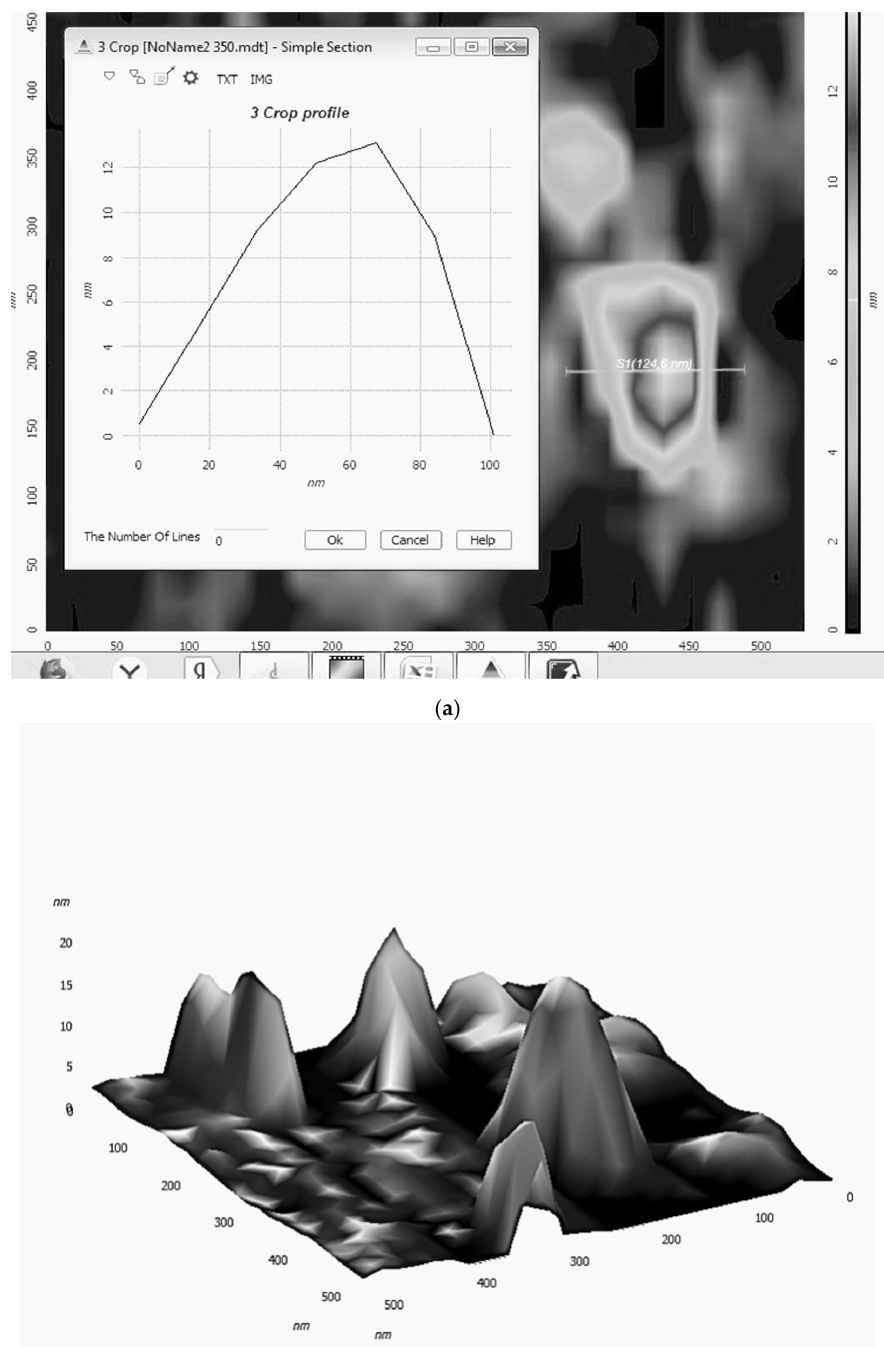
Figure 6. ( a ) AFM two-dimensional image of supramolecular structures based on {Hem+PhOH+His} complexes and a two-dimensional image profile of these structures; ( b ) AFM three-dimensional image of supramolecular structures, based on {Hem+PhOH+His}